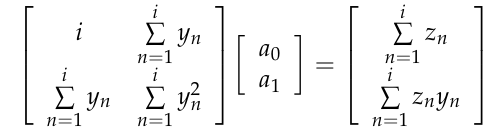
Figure 5. Schematic diagram of the pitch deviation